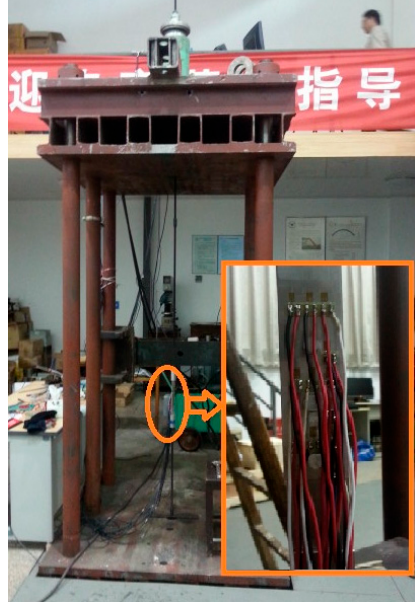
Figure 6. Multi-function testing machine.